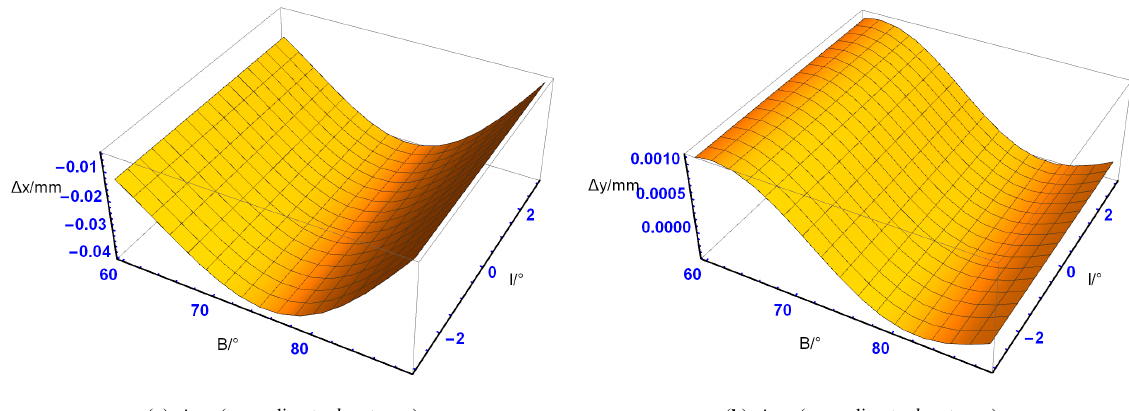
Figure 16. The distribution of (△ 𝑥,△ 𝑦) when expanding to 𝑘 (cid:2871) terms (based on 𝑒 ).